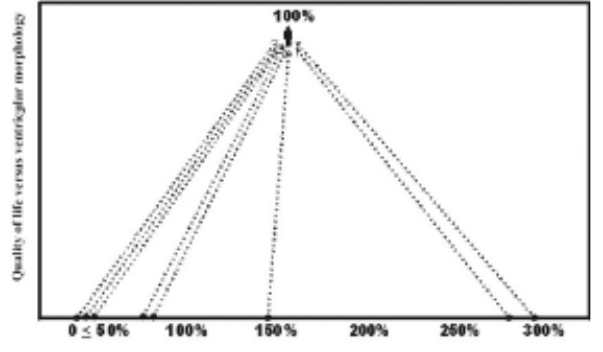
Figure 4 – Comparative analysis of the post-operative improvement in the physical, emotional and social well being and the quantitative estimate of the ejection fraction improvement after partial left